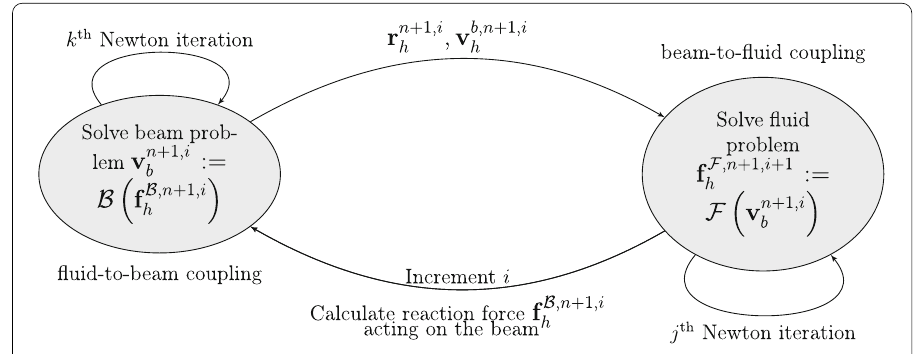
Fig. 5 Visualization of the one-way fluid and solid coupling schemes. In the visualization, B , F represent suitable operators for the solution of the nonlinear beam problem, and for the solution of the nonlinear fluid problem,